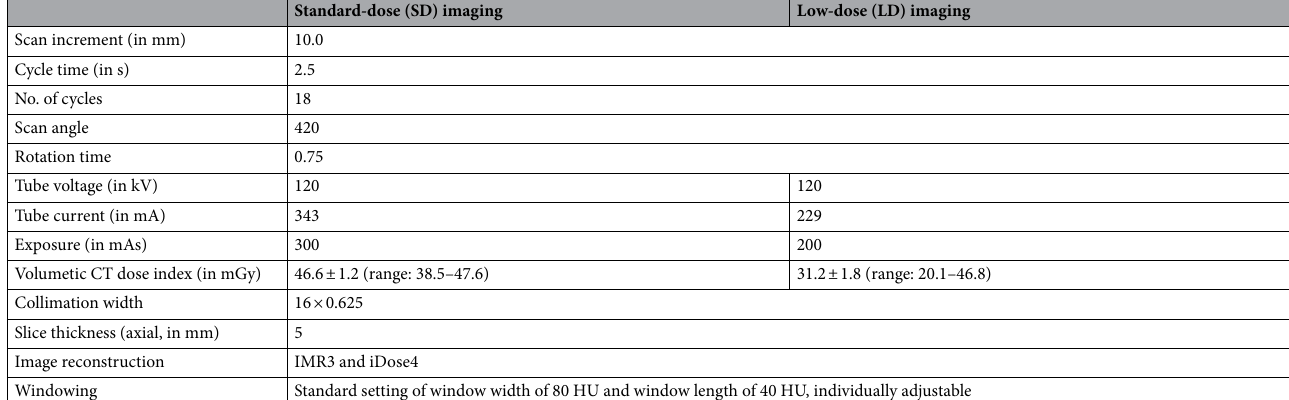
Table 1. Scanning details and image reconstruction for scanning with standard dose (SD) and low dose